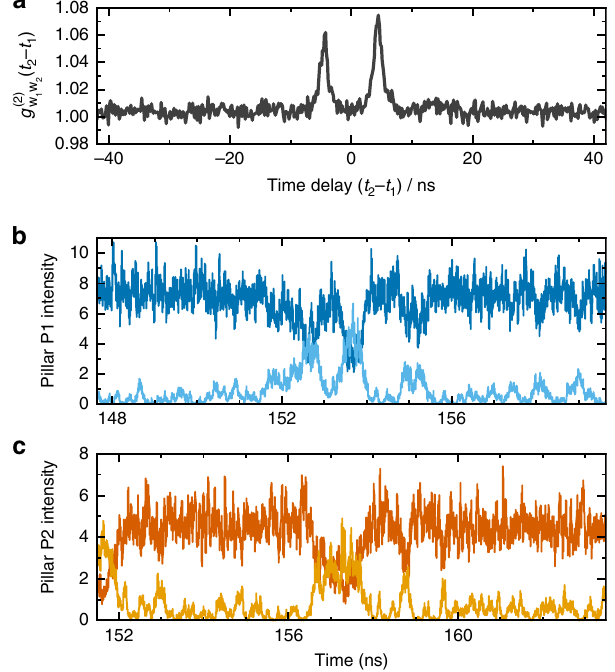
Fig. 5 Intensity cross-correlations of two coupled micropillar lasers. a Intensity cross-correlation g ð 2 Þ w ð t 2 (cid:1) t 1 Þ of the weak modes of pillars P1 and 1 w 2 P2. The weak modes were tuned to resonance ( ν w = 0) in face-to-face con fi guration (see con fi guration a in Fig. 1) at injection currents I P1 = 27.7 μ A and I P2 = 24.5 μ A. The two main peaks at 4.3 ns suggest leader-laggard synchronization of the intensity fl uctuations between the lasers. One roundtrip (7.7 ns) further, at 12 ns, weaker revival peaks are barely observable. b, c Simulated intensity dynamics, showing the leader-laggard behavior of the two coupled micropillars P1 (panel b , upper trace: strong mode, lower trace weak mode) and P2 (panel c , upper trace: strong mode, lower trace weak mode) at injection currents of I P1 = 27.1 μ A and I P2 = 24.2 μ A. The time axis for pillar P2 has been shifted with respect to pillar 1 by 3.85 ns, i.e., the optical distance between the two micropillars. This illustrates the delayed correlation of the intensity fl